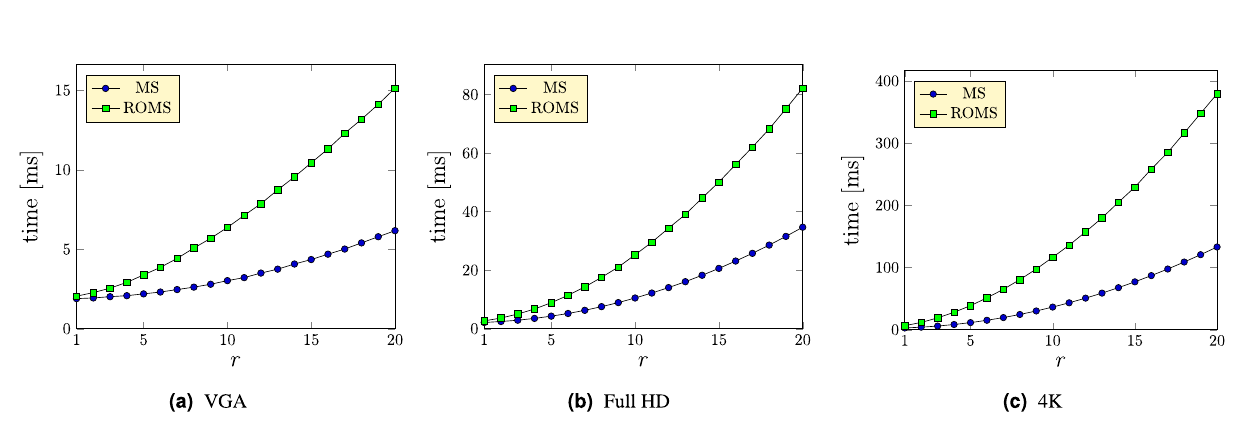
Figure 6. Comparison of computational efficiency of ROMS with the MS filter for varying block radius r and α = 3 on test images with VGA, Full HD and 4 K